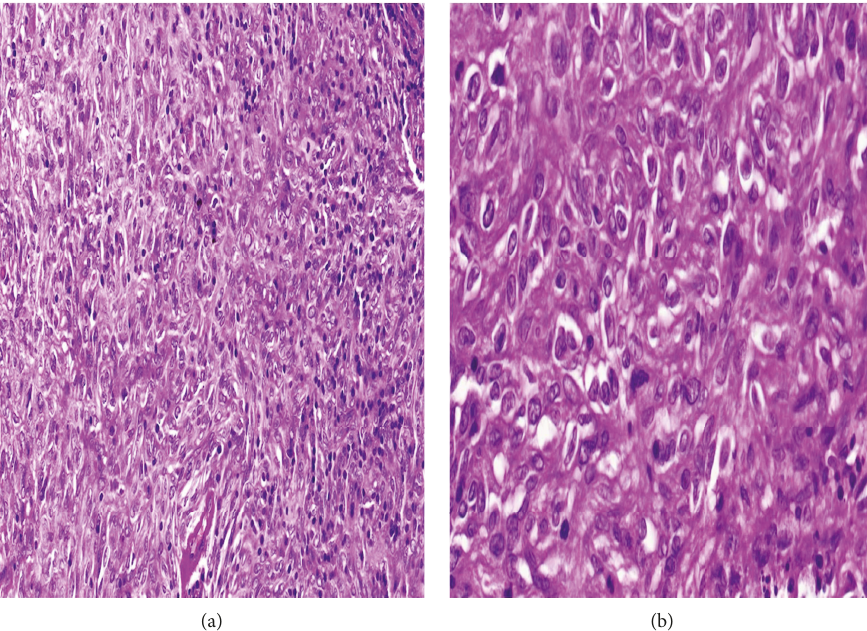
Figure 5: (a) Tumor cells are arranged in storiform pattern and as short fascicles. Tumor cells are intermixed with scattered lymphocytes (hematoxylin and eosin; magni fi cation, 200x). (b) Tumor cells are oval to elongated with indistinct cytoplasmic border and ovoid nucleus with few of them showing prominent nucleoli (hematoxylin and eosin; magni fi cation,